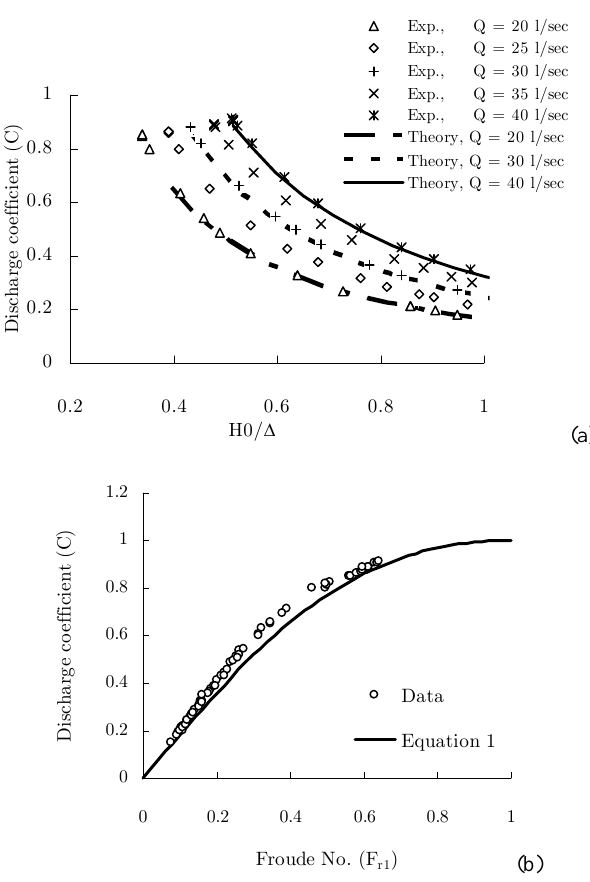
Fig. 11. Discharge coefficient ( C ) variation versus upstream energy head – non-dimensioned by weir height (a) , discharge coefficient variation versus Froude no. on weir crest (b) .